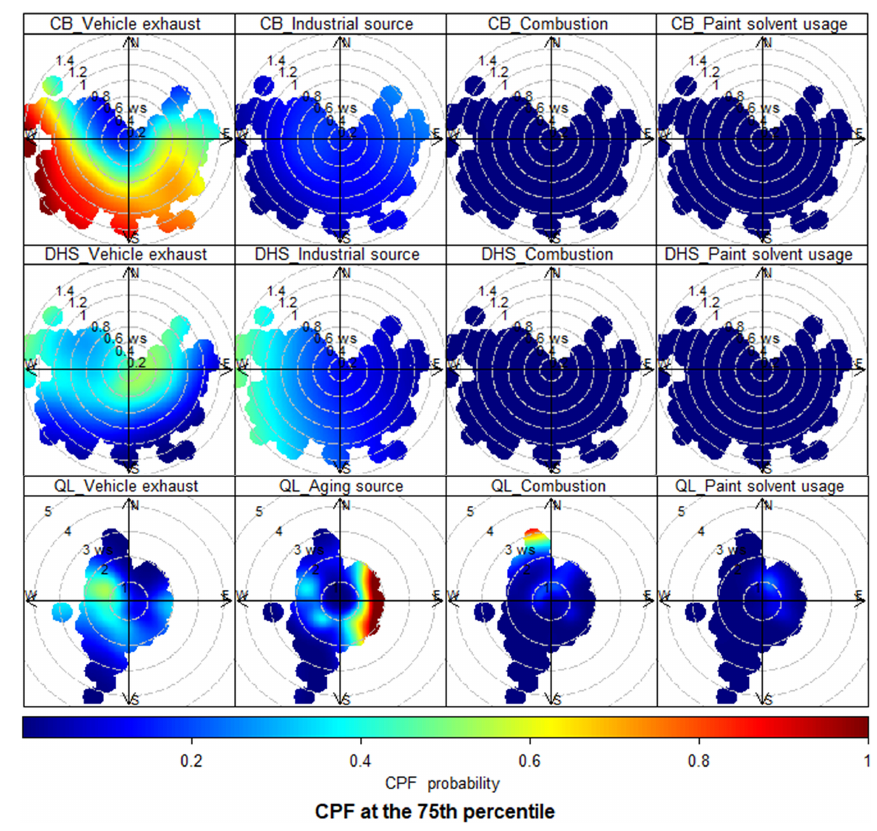
Figure 9. Polar plot of primary VOC sources in (a) CB, (b) DHS, and (c) QL sites based on the CPF